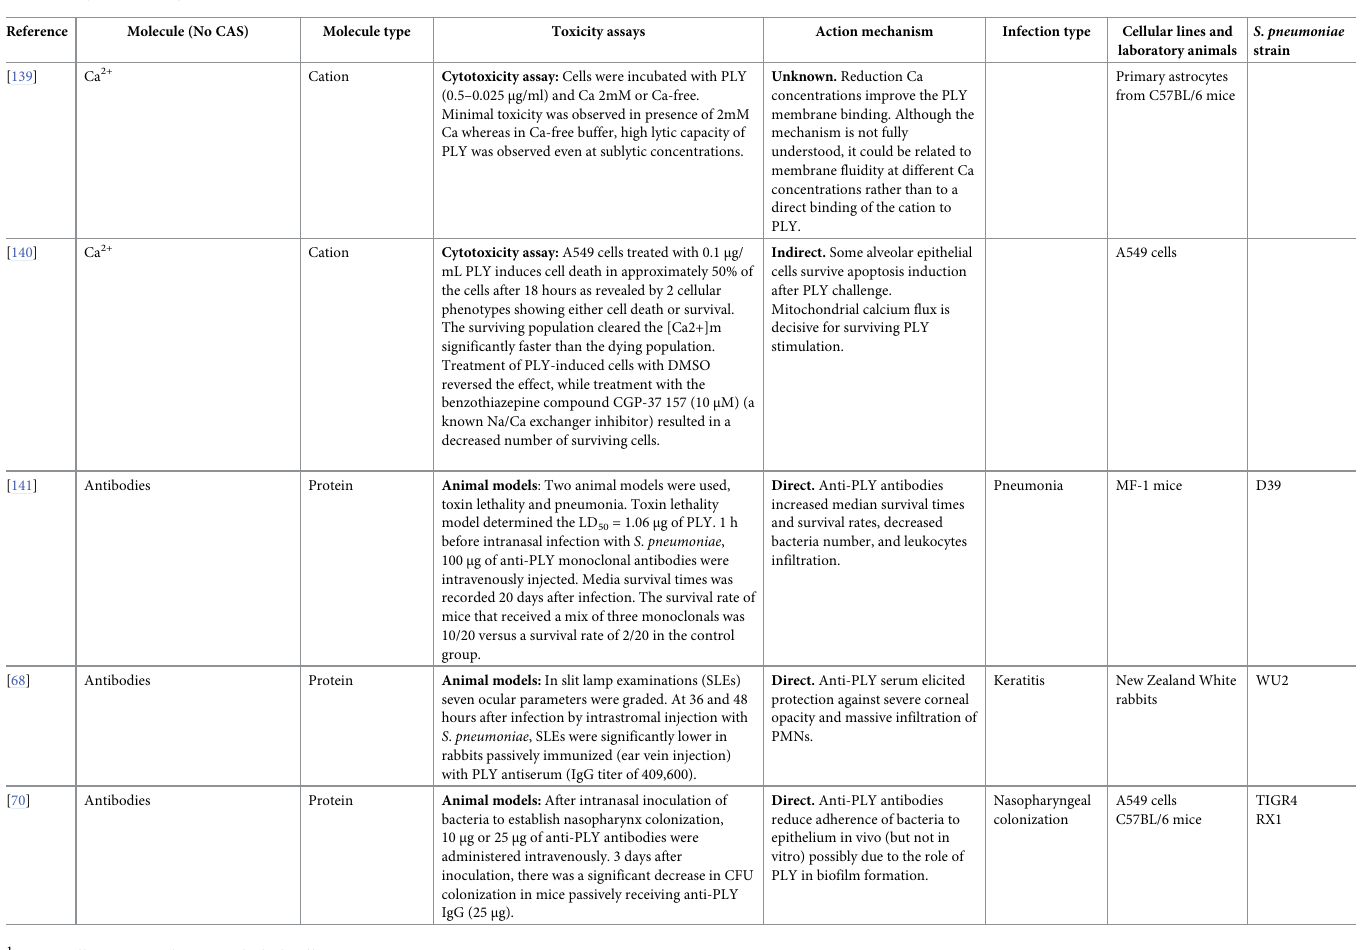
Protein Animalmodels: Afterintranasalinoculationof bacteriatoestablishnasopharynxcolonization, 10 μ gor25 μ gofanti-PLYantibodieswere administeredintravenously.3daysafter inoculation,therewasasignificantdecreaseinCFU